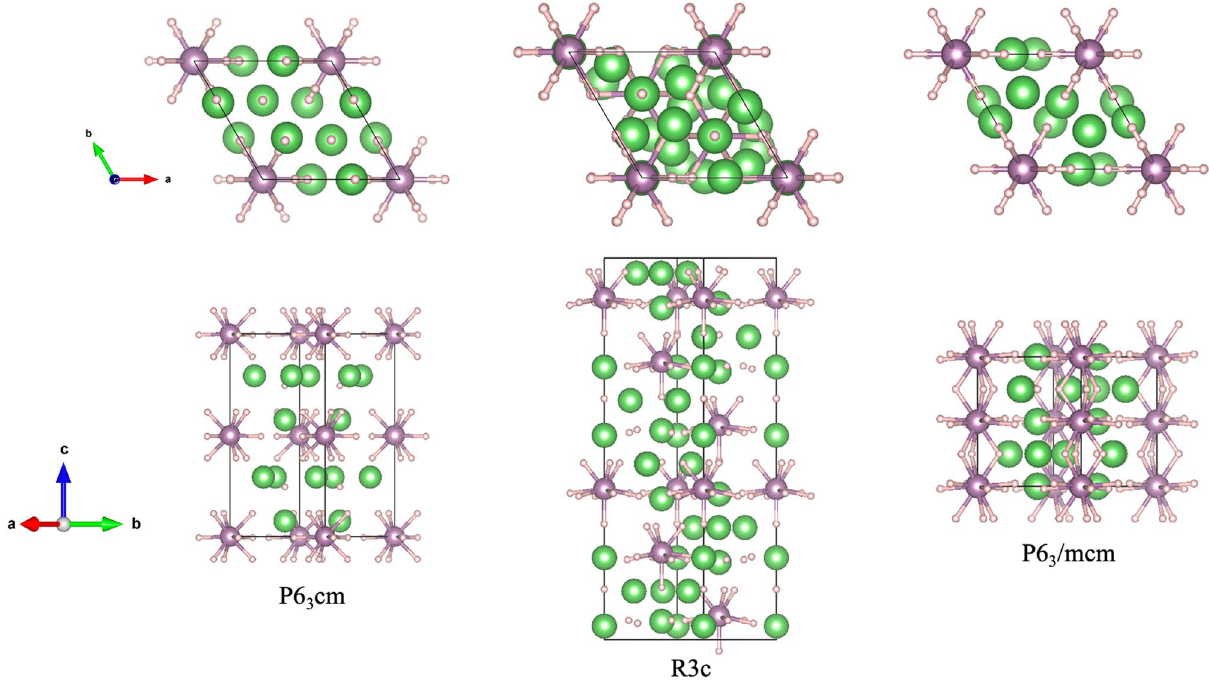
Figure 1. The crystal structures of Li 5 MoH 11 . The green, purple, and pink spheres represent, respectively, Li, Mo, and H atoms. (drawn by VESTA (ver. 3.4.7) 65 (URL https ://jp-miner als.org/vesta /en/downl